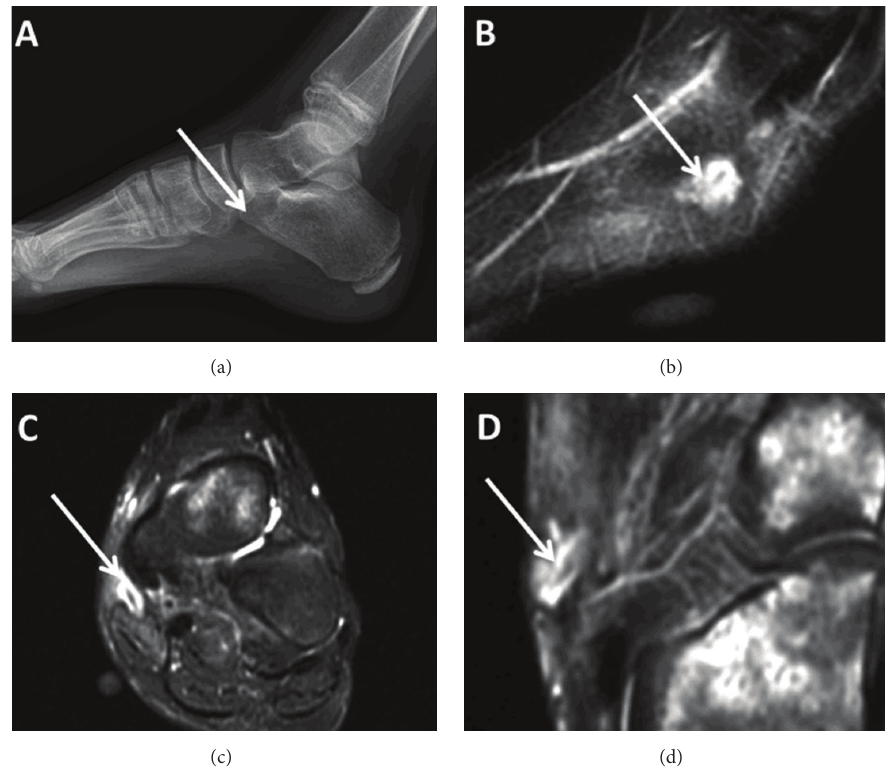
Figure 1: (a) X-ray and ((b)–(d)) sagittal, axial, and coronal MRI, respectively, indicating abscess with potential foreign body.